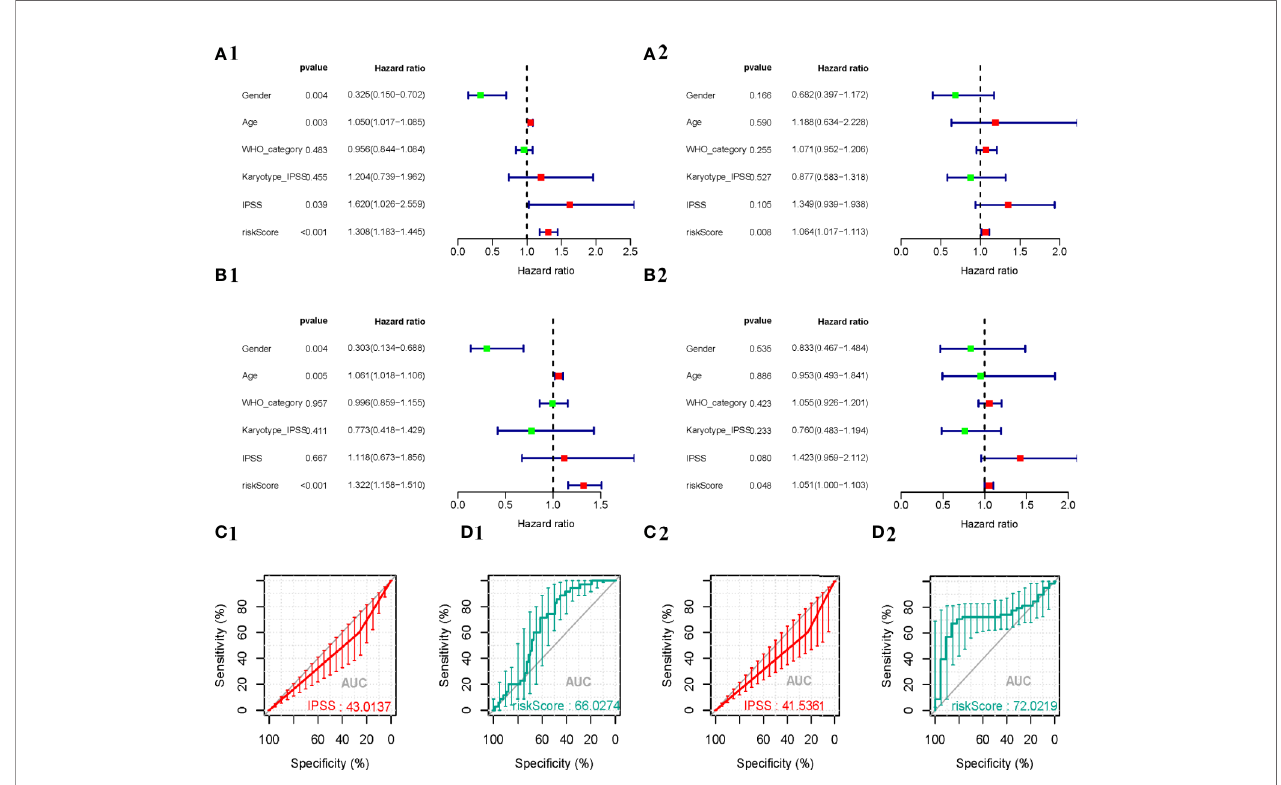
FIGURE 6 | Predictive performance of prognostic indicators based on ARGs. The result of Cox regression analysis in MDS are shown as forest plots, including univariate analysis outcomes in the training (A1) and validation (A2) cohorts, and multivariate analysis outcomes in the training (B1) and validation (B2) cohorts. Survival-dependent receiver operating characteristic (ROC) curves validate the prognostic signi fi cance of IPSS in the training (C1) and validation (C2) cohorts and ARGs-based prognostic indicators in the training (D1) and validation (D2)